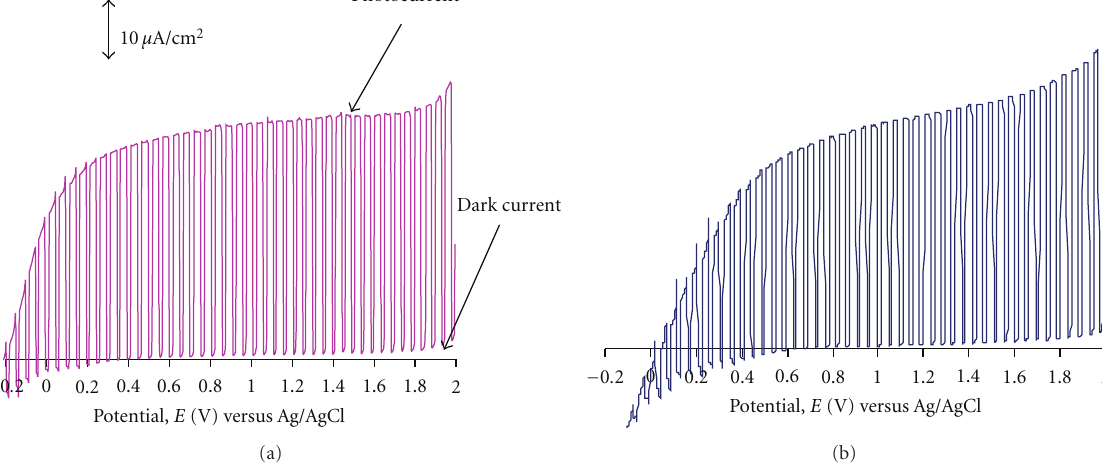
Figure 8: Photoresponse of (a) TNT/EDTA and (b) TNT prepared at 20V for 1h at pH 4.5. All the photocurrent measurement were obtained using 10ppm methyl orange with 0.1 M KCl as supporting electrolyte from 300 W halogen lamp at scan rate of 20 mV/s.